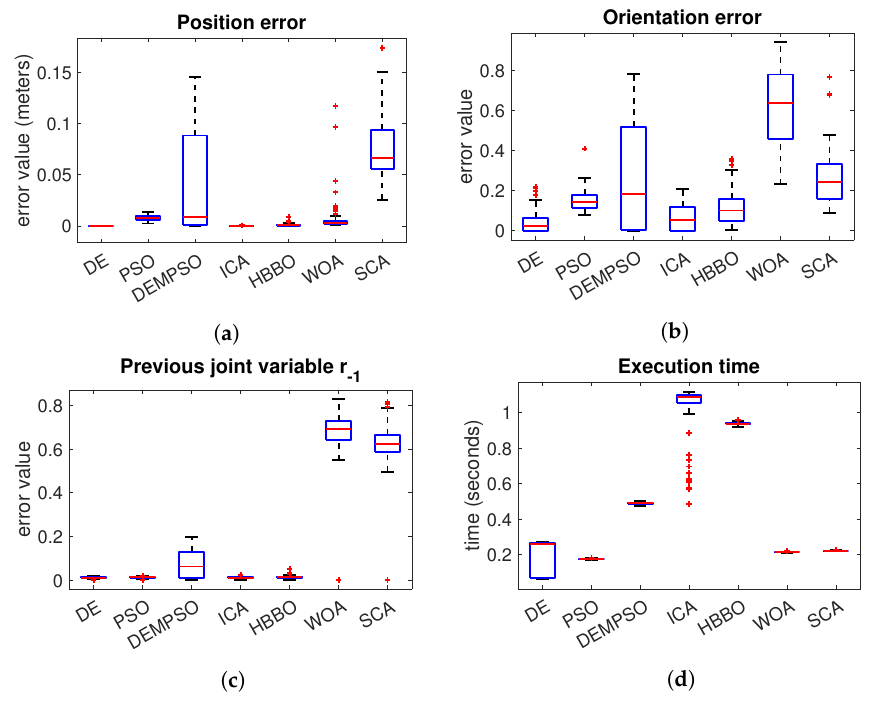
Figure 10. Lemniscate path tracking results with the Fanuc robot. ( a ) Fanuc end-effector position error (5); ( b ) Fanuc end-effector orientation error (15); ( c ) Fanuc joint variables error (16); ( d ) Execution time for each point in the path.